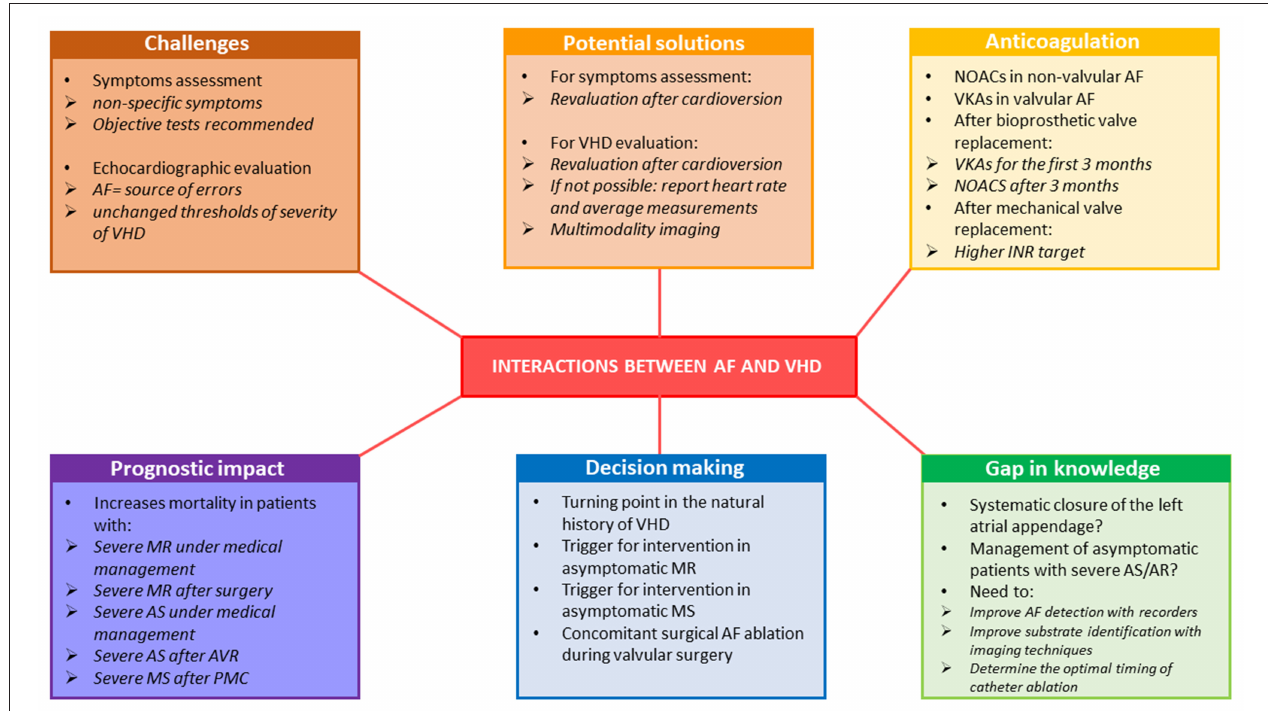
FIGURE 3 | Representative of the interaction between AF and VHD in terms of diagnostic challenges and prognostic and therapeutic considerations. AF, atrial fibrillation; AR, aortic regurgitation; AS, aortic stenosis; INR, international normalized ratio; MR, mitral regurgitation; MS, mitral stenosis; NOAC, non-vitamin K oral anticoagulants; PMC, percutaneous mitral commissurotomy; VHD, valvular heart disease; VKA, vitamin-K